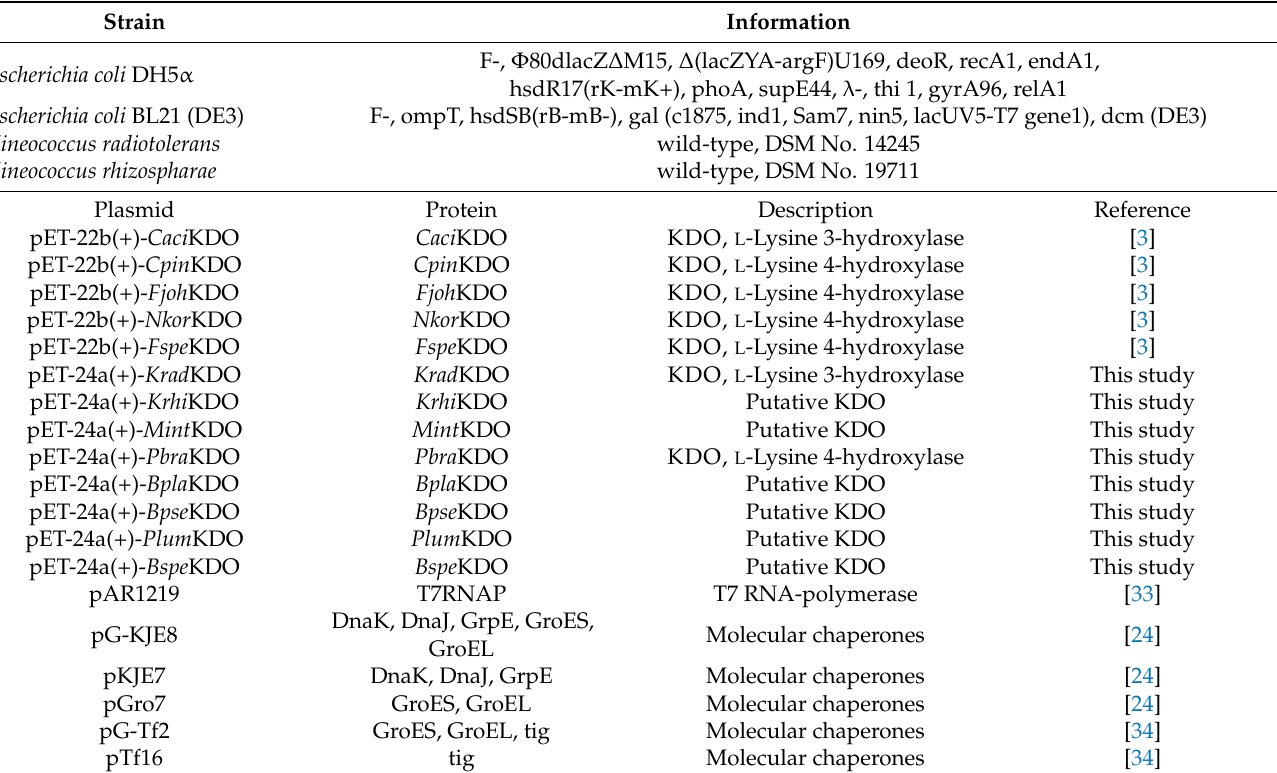
Table 2. Strains and plasmids used in this